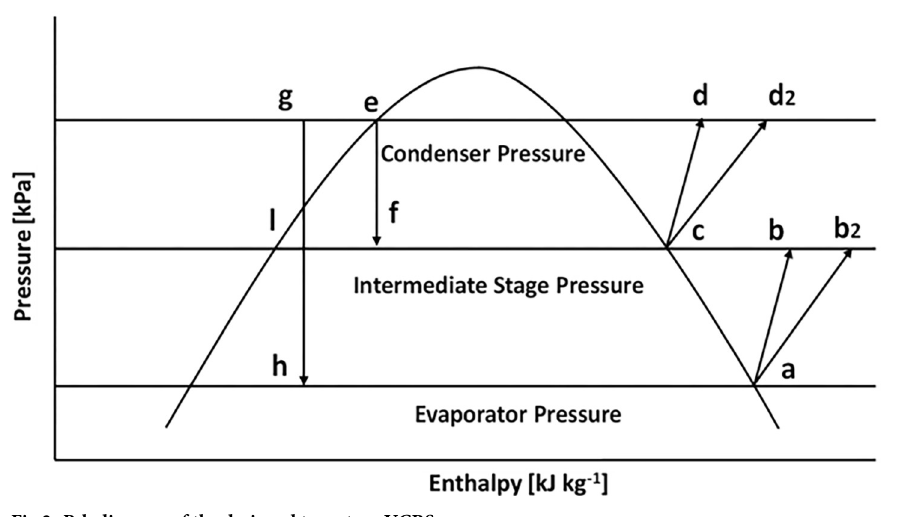
Fig 2. P-h diagram of the designed two-stage